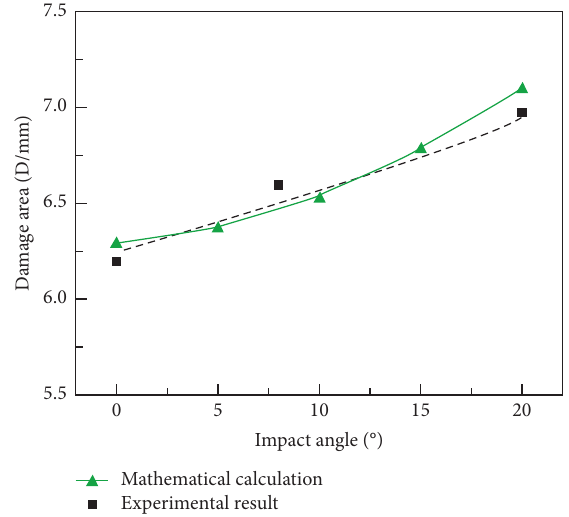
Figure 10: Effect of impact angle on damage area (test time with 60s; particle diameter with1.0 mm; water-jet impact velocity with 205m/s).